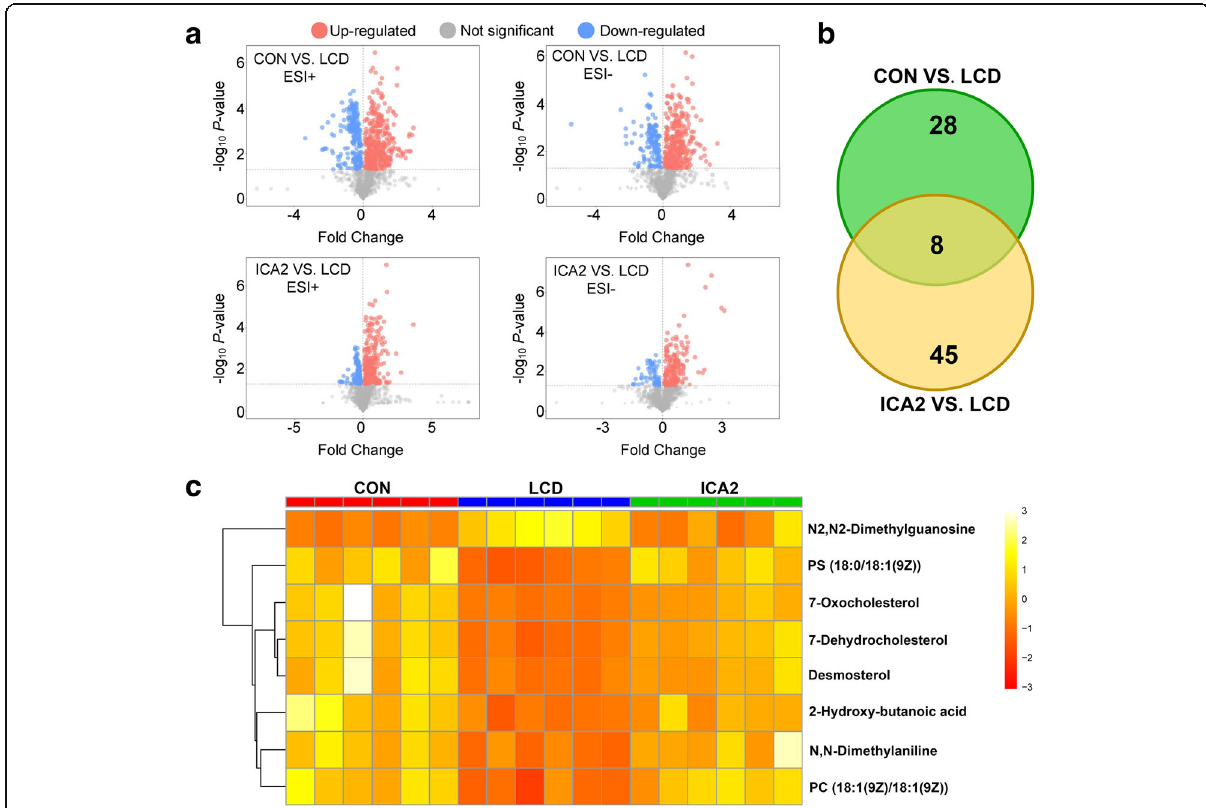
Fig. 7 Differential metabolites induced by ICA treatment. a Volcano map of metabolites for groups (CON vs. LCD and ICA2 vs. LCD) in positive and negative iron modes. b The shared and unique numbers of differential metabolites in the Venn diagram from CON vs. LCD and ICA2 vs. LCD. c Heat map and hierarchical clustering of 8 shared differential metabolites among the CON, LCD and ICA2 groups. ICA, icariin. CON, base diet. LCD, low calcium diet. ICA2, low calcium diet supplied with 2.0 g/kg ICA